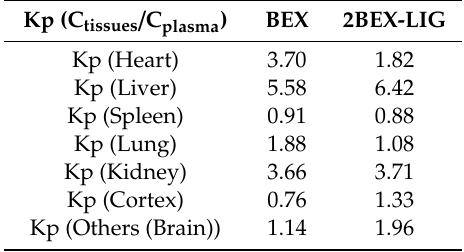
Table 5. The tissue distribution parameter Kp (C tissues / C plasma ratios) of bexarotene (BEX) in